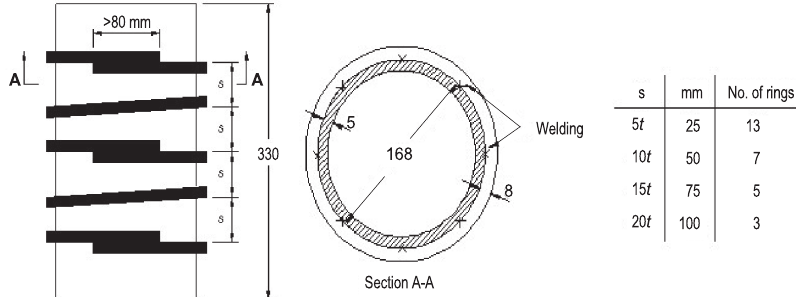
Fig. 2. Details of external steel rings of